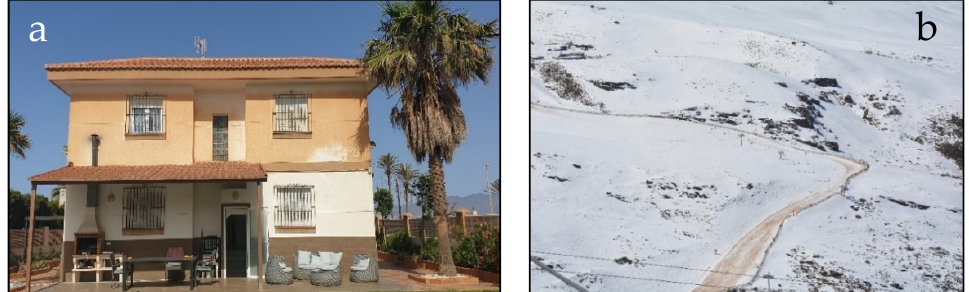
Figure 2. Haze deposited in a house façade (partially cleaned), after haze events in Almería, Spain ( a ) and effects of haze event in Sierra Nevada, Granada, on 8 April 2022 ( b ) (photographs from authors).